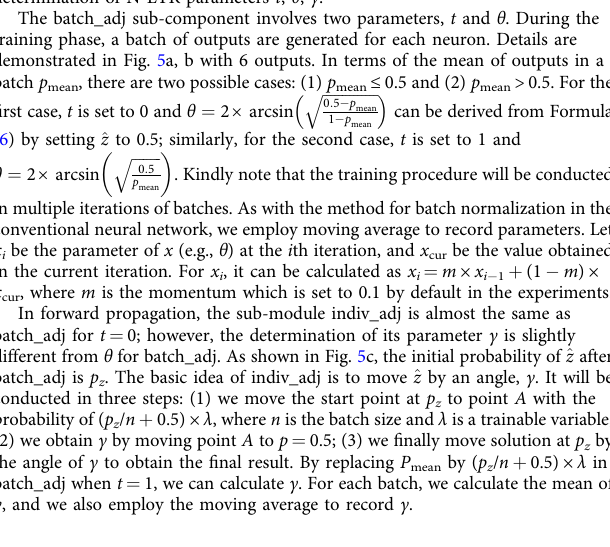
Algorithm 3 : QF-FB: simulating